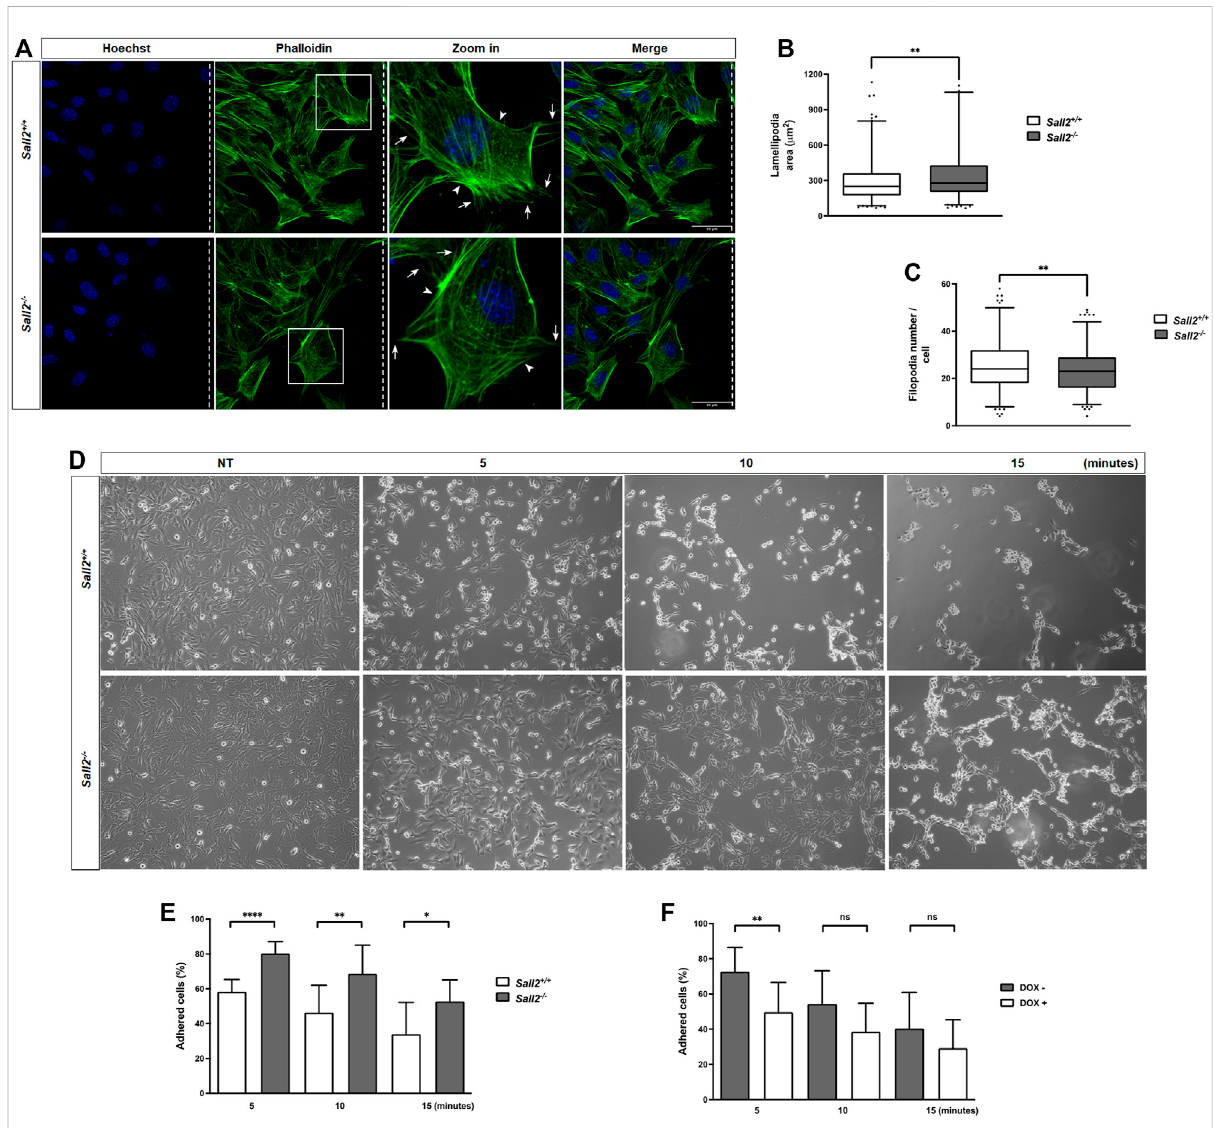
FIGURE 2 Sall2 decreases the lamellipodia size and promotes cell detachment. (A) Representative confocal images (40 ×) from Sall2 +/+ and Sall2 − / − iMEFs after cell migration induction at 16 h. Cells were fi xed and stained with phalloidin (F- actin, green) and Hoechst (nuclei, blue). Dashed lines indicate thepositionofthewound, andarrowsandarrowheads showthe fi lopodiaandlamellipodia,respectively. (B) Quanti fi cationoflamellipodiaareafrom images obtained in (A) . (C) Quanti fi cationof fi lopodianumberfromimagesobtained in (A) .Dataofcellprotrusionsanalysis areshownasabox- and-whiskersplotfromthreeindependentexperiments.Thewhiskersrepresentthe2.5thand97.5thpercentile,theboxextendsfromthe25thtothe 75th percentile and the line indicates the median. For each experiment at least 100 cells were analyzed per genotype. (D) Sall2 +/+ and Sall2 − / − iMEFs were treated with EDTA-containing solution for the indicated times, then fi xed and evaluated by microscopy. Representative phase contrast images (10x) from each time point are shown. (E,F) Quanti fi cation of the percentage of adherent cells from Sall2 +/+ and Sall2 − / − iMEFs (E) and the Tet-On Sall2 iMEFs inducible model (F) performed as described in the MATERIALS AND METHODS section. Data of cell detachment assays are expressed as mean ± SD from three independent experiments performed in triplicate. (n.s, not signi fi cant, * p = 0.01 to 0.05, ** p = 0.001 to 0.01, **** p ≤ 0.0001; unpaired t